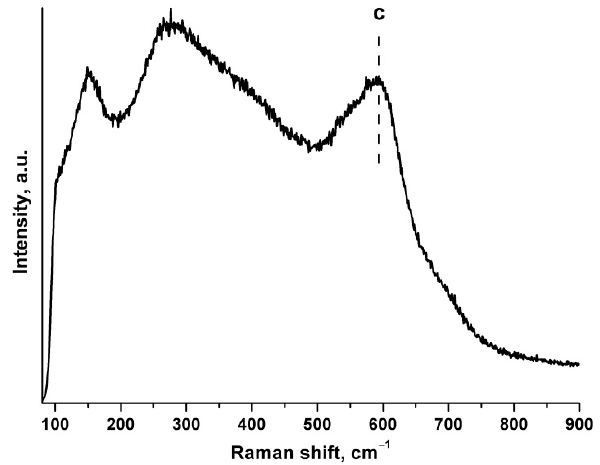
Figure 2. Raman spectrum of (ZrO 2 ) 0.805 (Y 2 O 3 ) 0.188 (Pr 2 O 3 ) 0.007 crystal.